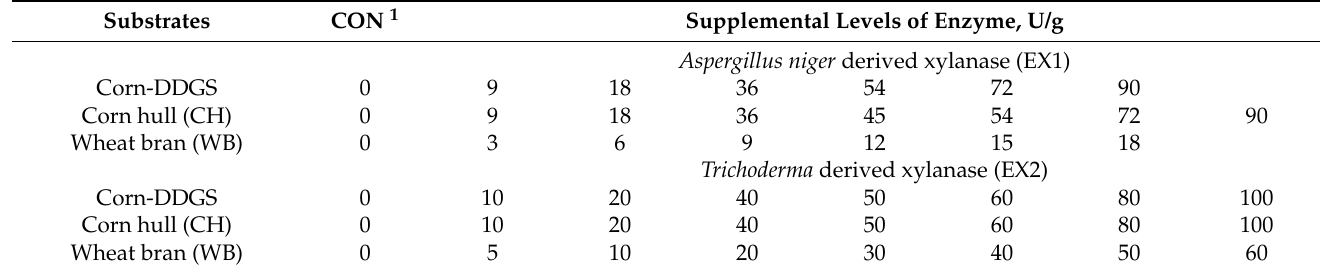
Table 1. Different levels of core endo-xylanase added to multiple substrates.